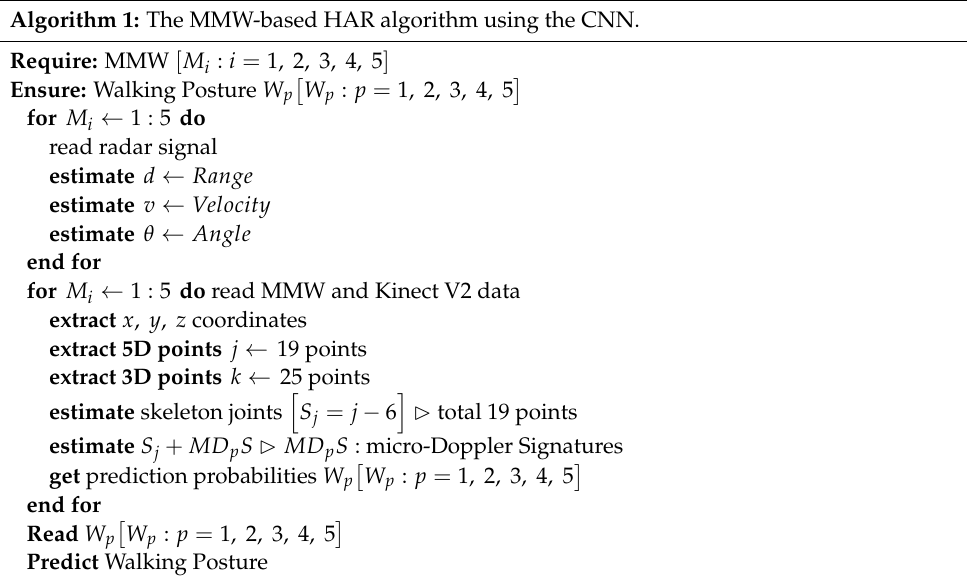
Algorithm 1: The MMW-based HAR algorithm using the